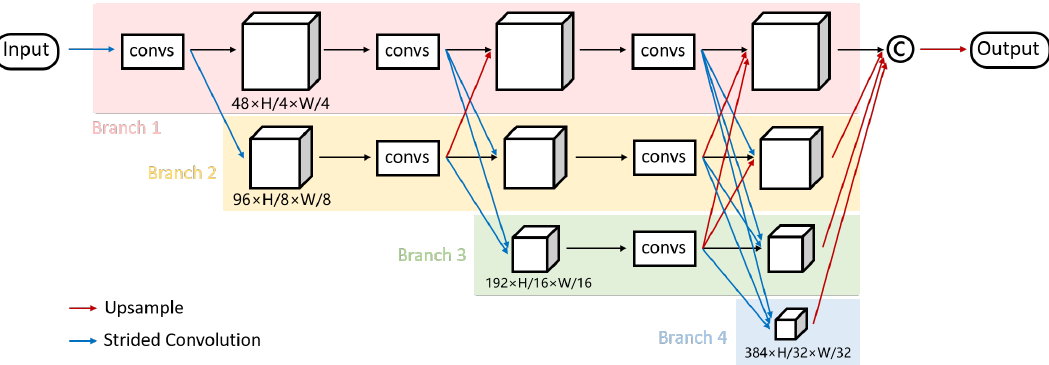
Figure 2. The baseline high-resolution network. Each ’convs’ box refers to a convolution block consisting of cascaded convolutional